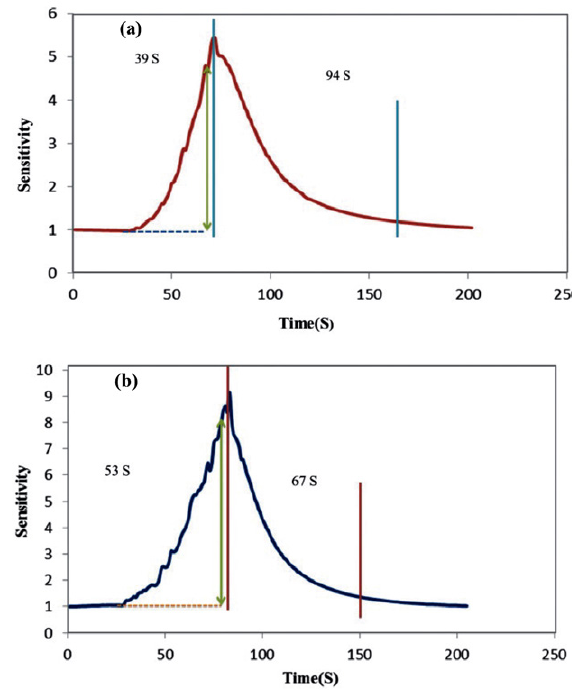
Figure 8 . A single-cycle response–recovery characteristic curves of calcinated CuO nanofibers to (a) 200 ppm H 2 and (b) 700ppm CO at 175°